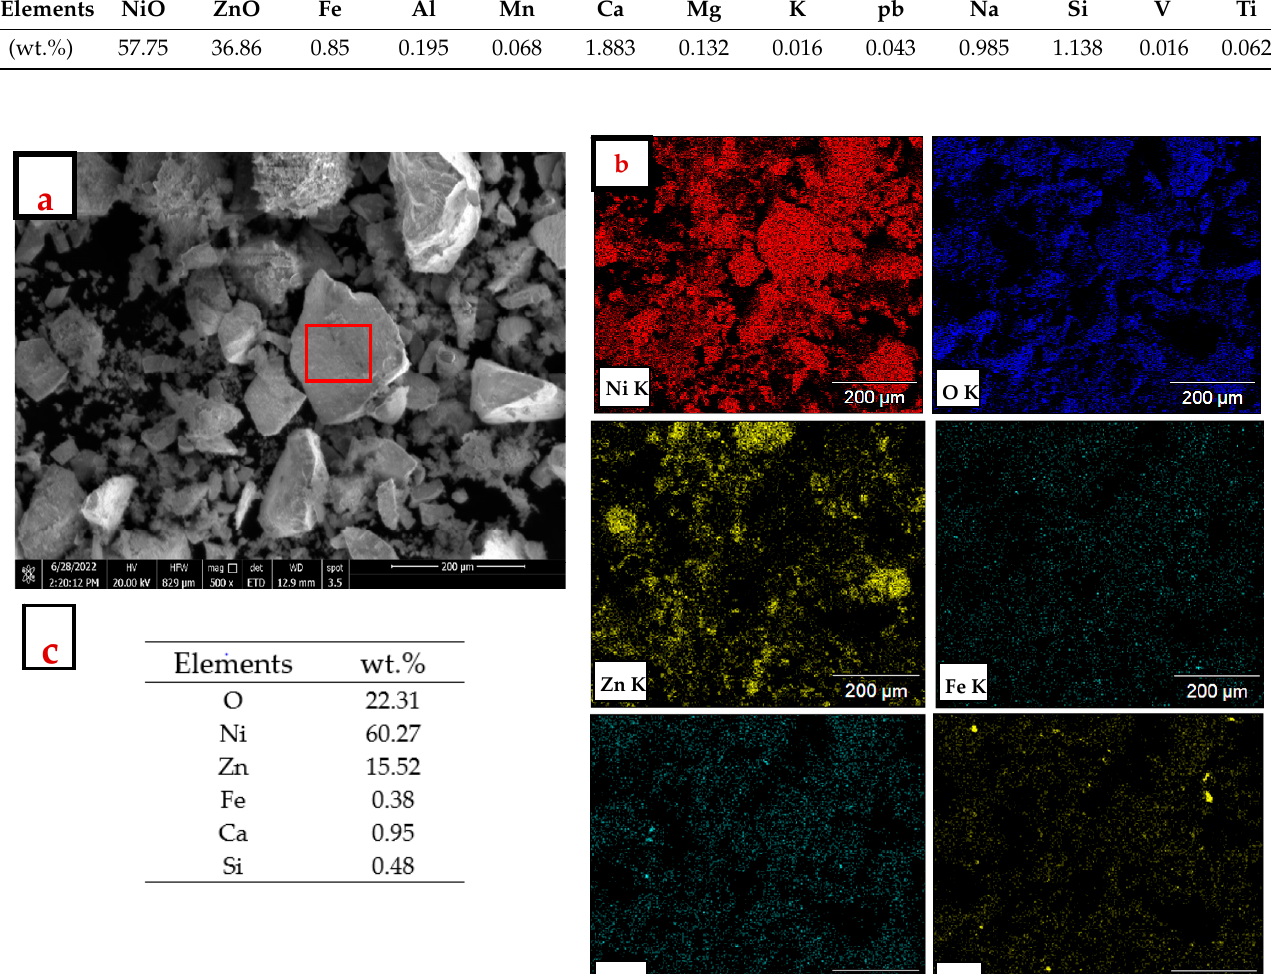
Figure 13. XRD patterns of NiO-ZnO precipitate.